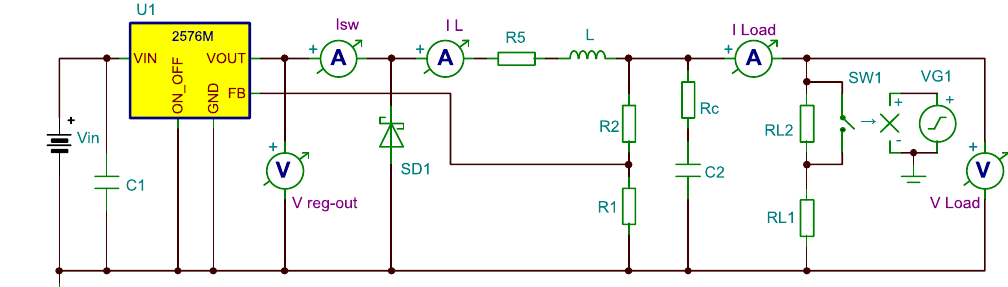
Figure 7. Wiring diagram of the investigated circuit in the TINA program.